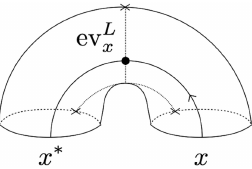
Figure 9 . The composition of the multiplication and the counit defines a non-degenerate pairing, which can be used to regard V